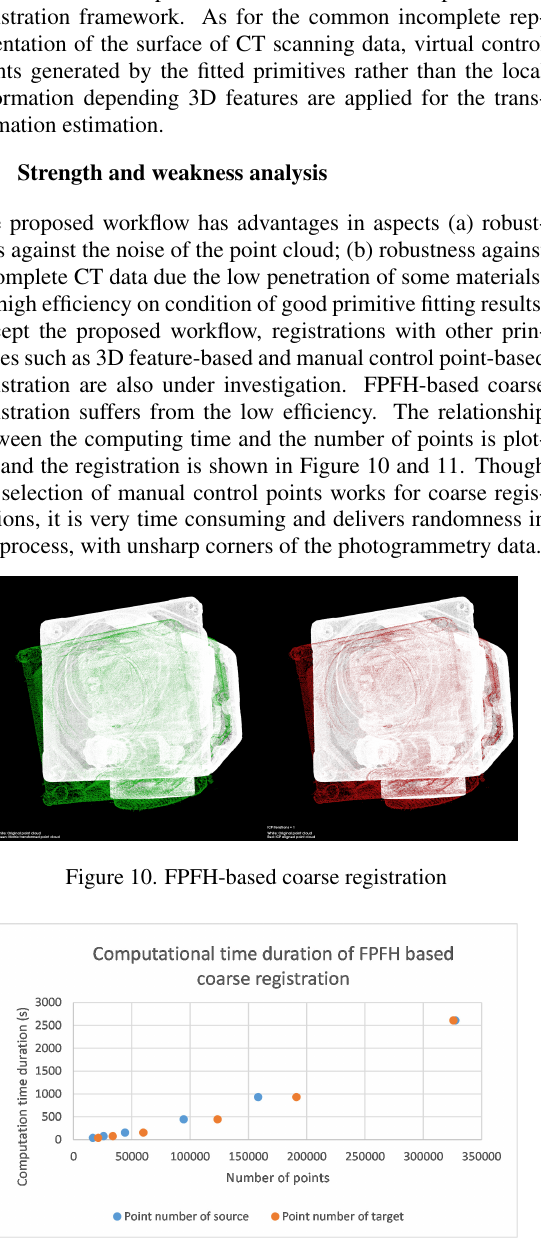
Figure 11. FPFH-based computation